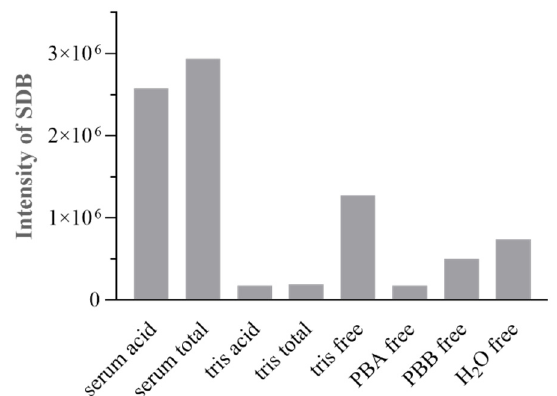
Figure 4. MS intensity of SDB peak for: serum acid (acid H 2 S from serum), serum total (total H 2 S from serum), tris acid (acid H 2 S from Tris-HCl), and tris total (acid H 2 S from Tris-HCl). Tris free (free H 2 S from Tris-HCl), PBA free (free H 2 S from PB-A), PBB free (free H 2 S from PB-B), and H 2 O free (free H 2 S from H 2 O).